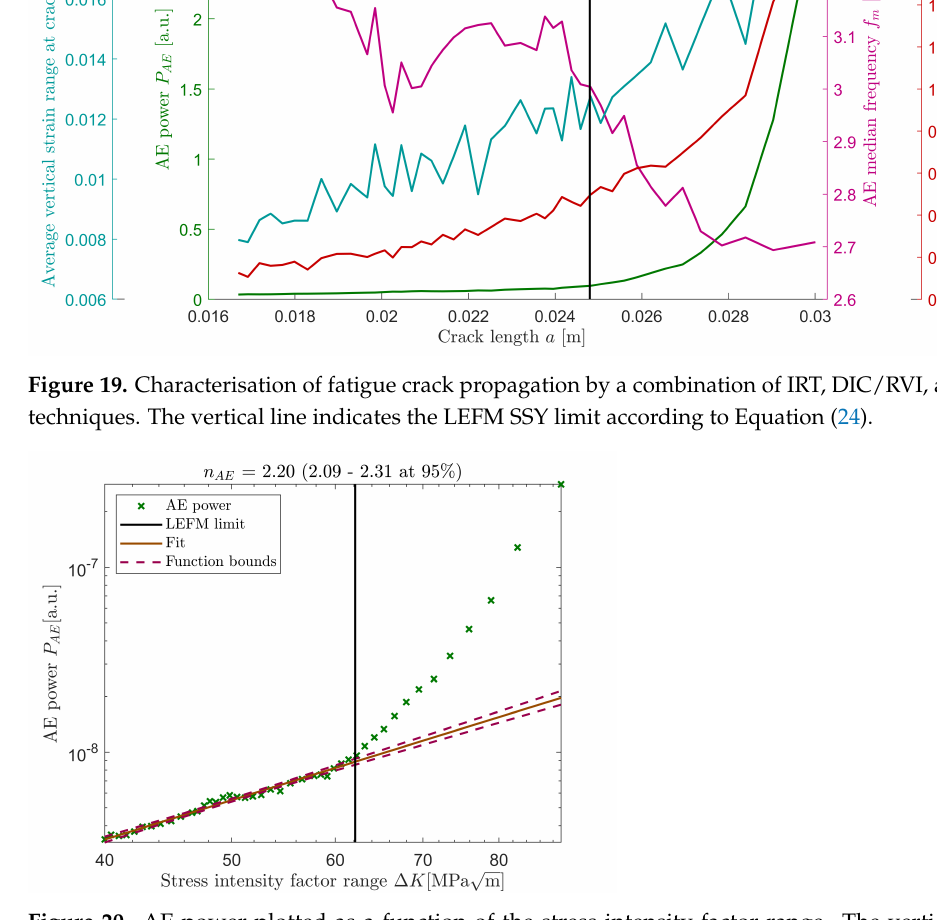
Figure 20. AE power plotted as a function of the stress intensity factor range. The vertical line indicates the LEFM SSY limit according to Equation